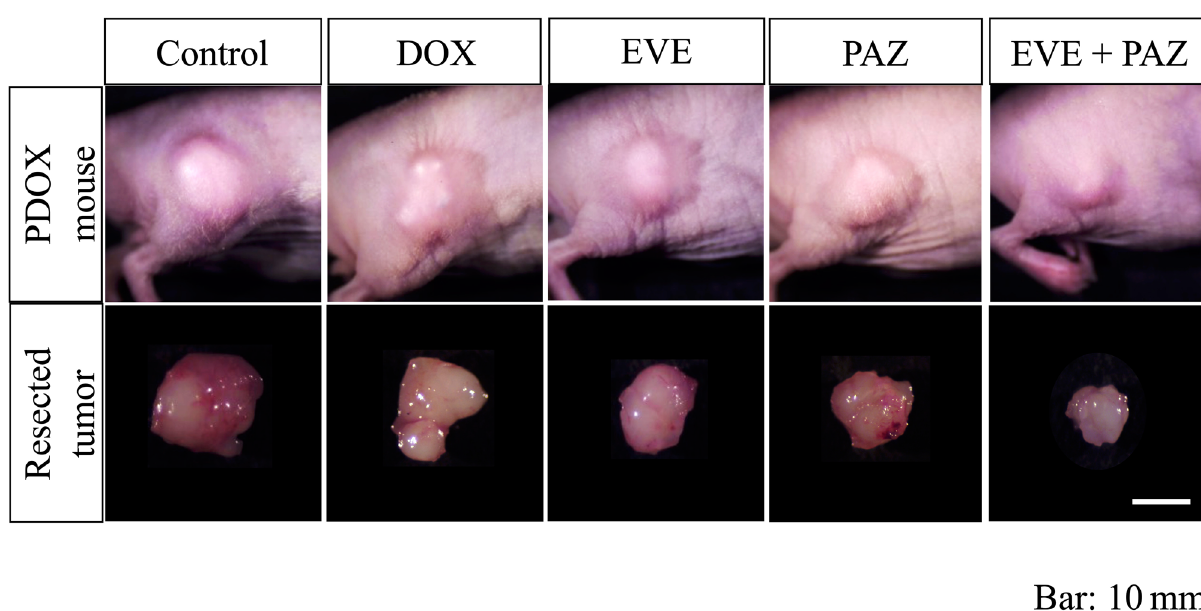
Figure 3. Photographs of control and treated in situ and resected tumors. The combination of EVE and PAZ inhibited osteosarcoma tumor growth in the PDOX model. Scale bars are 10